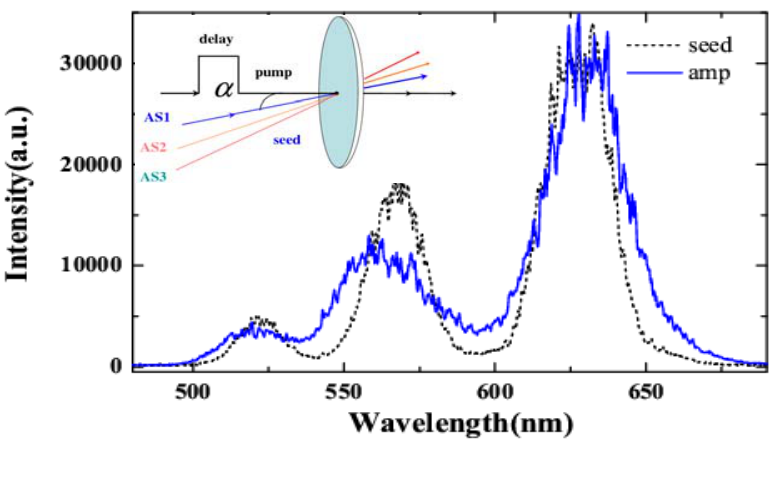
Figure 35. The spectral profiles of AS1, AS2, and AS3 without pump (black dash line). The blue solid line is the spectral profiles of AS1, AS2, and AS3 with pump. The inset is a schematic of the experimental setup; α is the crossing angle between pump and AS1